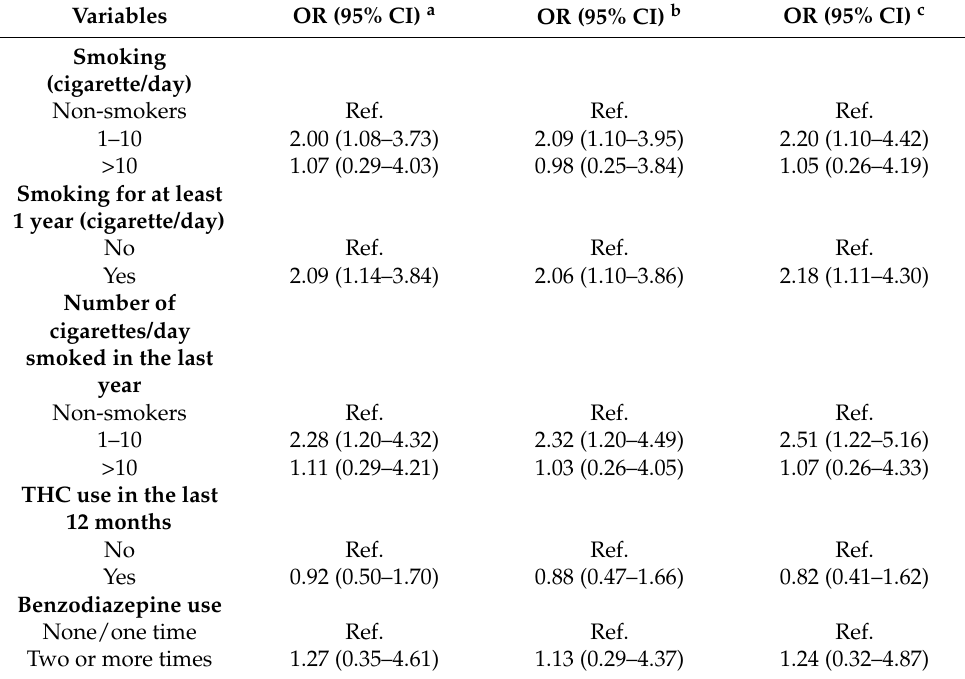
Table 4. Associations between subject habits and positive ASRS questionnaire evaluated by logistic regression